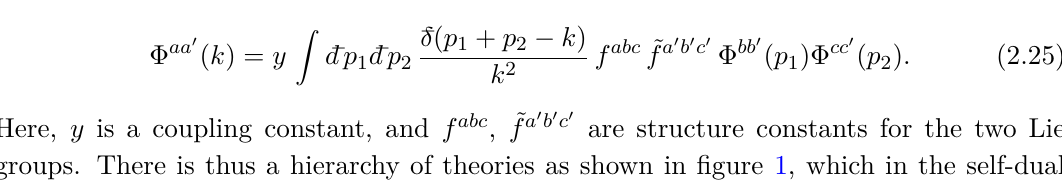
Figure 1 . Various field theories and the relationships between them. Figure taken from ref. [21]. or, in momentum